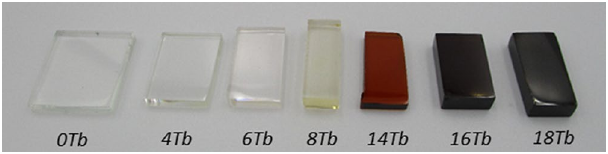
Figure 1. Photograph of BGB- x Tb glasses with different Tb 4 O 7